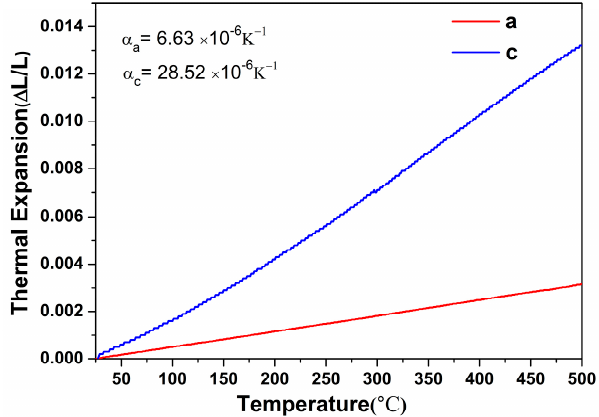
Figure 2 The thermal expansion of CYAM crystal along a and c axes.